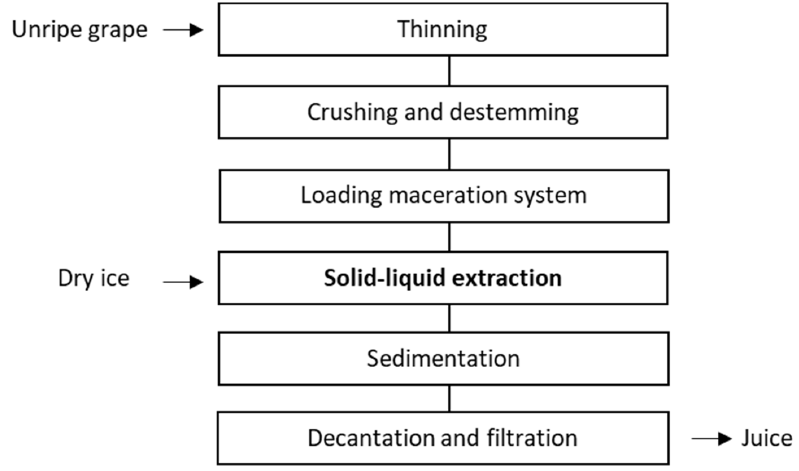
Figure 1. Scheme of process for juice production from unripe grapes.